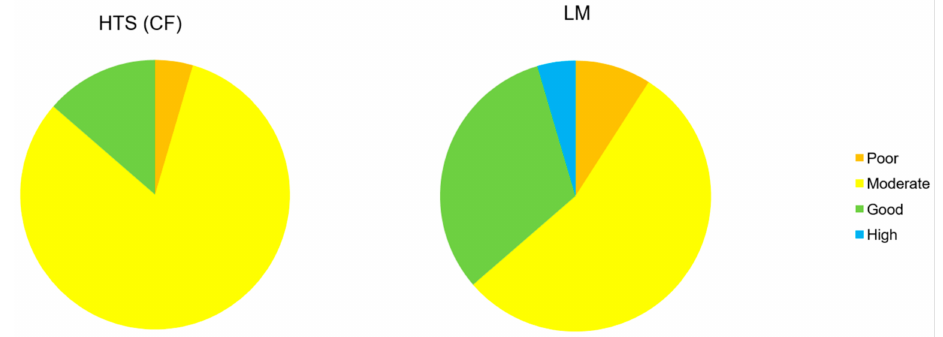
Figure 4. Proportion of the quality classes detected by both methods, morphological and